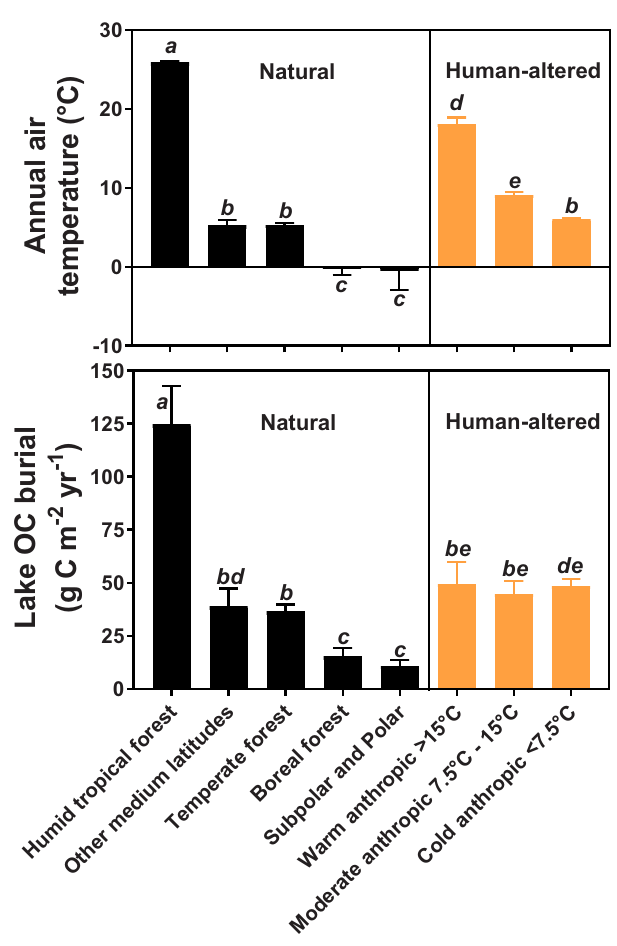
Fig. 2 Annual air temperature and recent OC burial in lake sediments among classes of natural and human-altered biomes around the world. Classes of lake biomes were ordered from right to left along the X-axis to represent the increasing trend in the annual air temperature. The bars and error bars represent the average and standard error, respectively, and equal letters represent no statistical difference (one-way ANOVA, post hoc Tukey test, p <